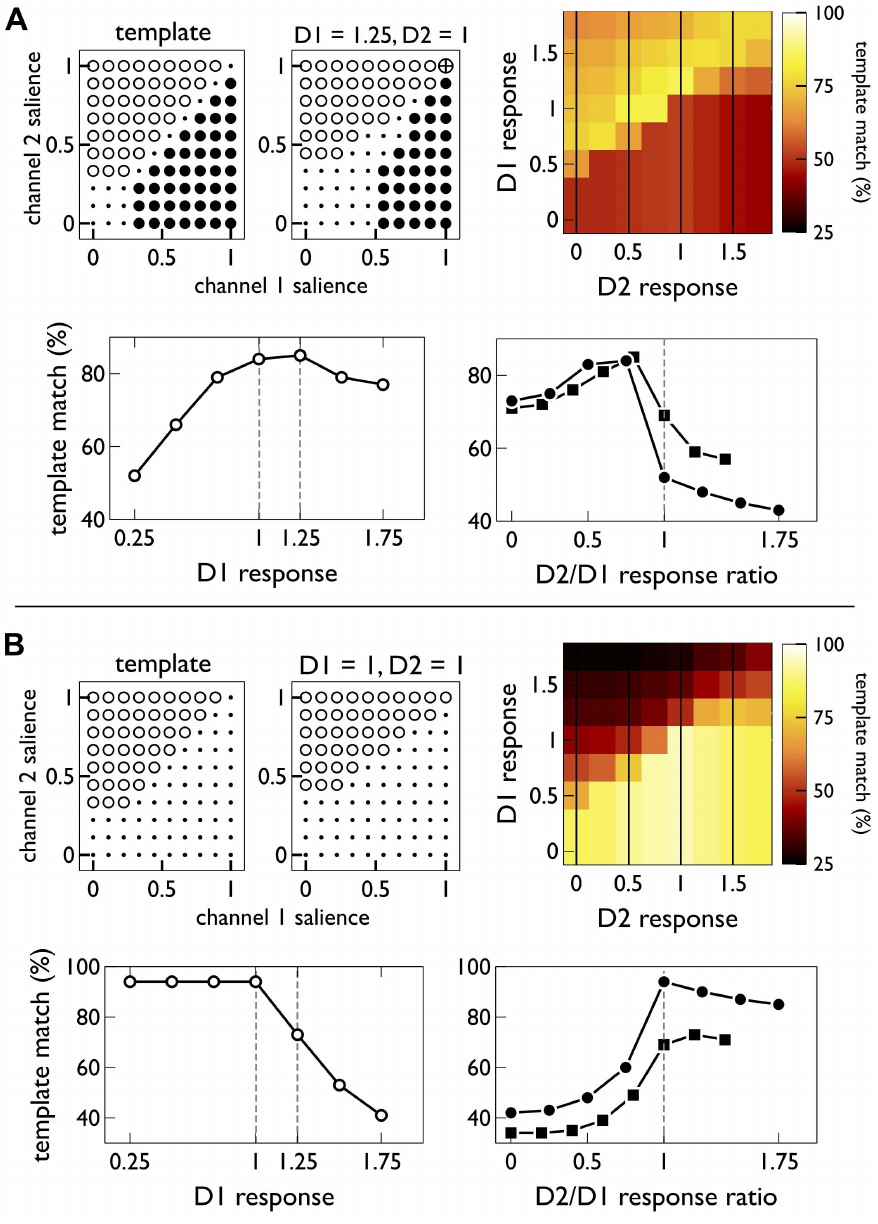
Figure 3. Linking action selection in basal ganglia to MSN responses. In all plots, neural ‘‘responsiveness’’ is the ratio of the population 9 s input value to output response; we abbreviate to ‘‘response’’ in axis labelling for brevity. (A and B) relate to action learning and extinction, respectively. The pairs of ‘‘bubble plots’’ in the top left of each panel show (i) an idealised selection template for a two-channel competition (left plot in each pair), with the key action on channel 1 and the control action on channel 2; and (ii) the best match to that template (at the D1 and D2 responsiveness noted above the plot). In each bubble plot, open symbols show an outcome of channel 2 selected, closed symbols show channel 1 selected, dots are no selection, and the crossed-circle shows both channels selected. The 2D colour plots (‘‘heat maps’’) show the template match for each D1/D2 responsiveness pair. The pairs of line plots show details of the corresponding colour map. The left hand line plots (open symbols) show the maximum template match for a given D1-MSN responsiveness; results at 1 and 1.25 are highlighted by the dashed lines. The right hand line plots (closed symbols) show cross sections through the 2D heat map (indicated by dashed grey lines therein) at D1 responsiveness of 1 (circles) and 1.25 (squares).